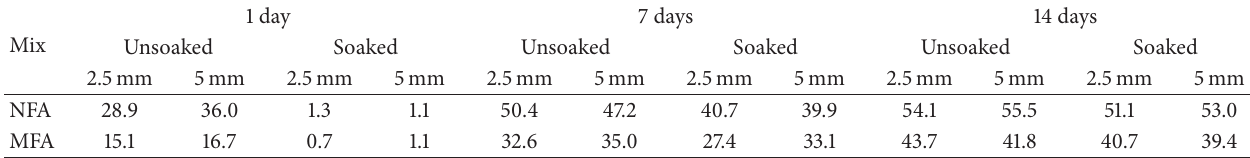
Table 2: Variation of CBR values for NFA and MFA under unsoaked and soaked conditions and at different curing periods.